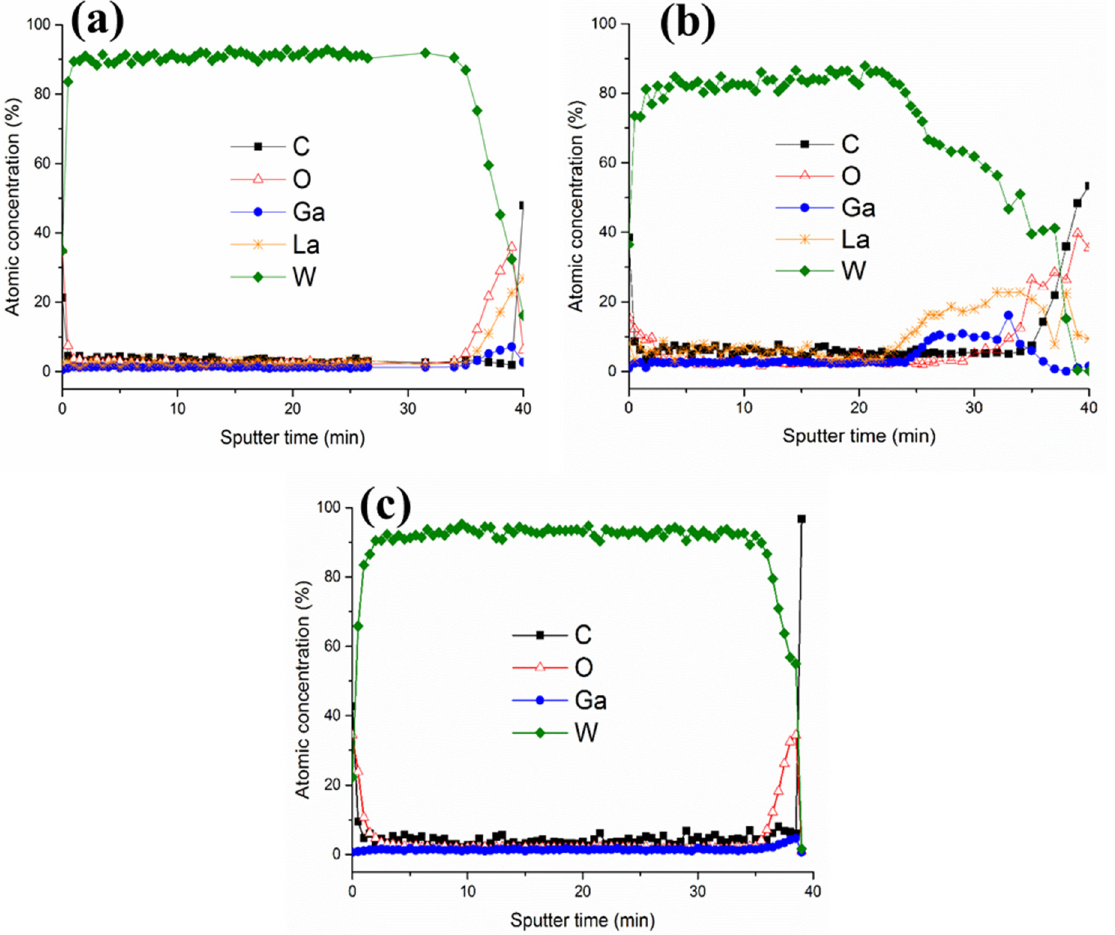
Figure 3. AES depth profiles made at ( a ) non ‐ defected region on W ‐ LGS, ( b ) around the blister location on W ‐ LGS, and ( c ) on W ‐ CTGS.